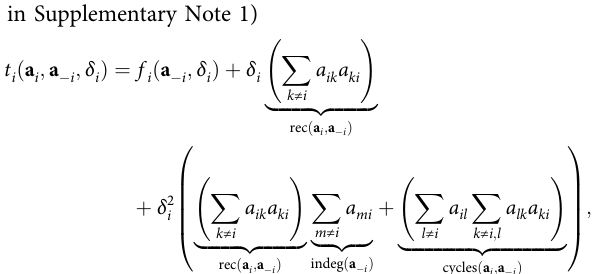
Fig. 2 Sketch of reciprocity and cycles. a The reciprocity of agent i is determined by the sum of the reciprocated ties. b The cycles of agent i are computed summing up all the length 3 cycles that starts and ends in node i